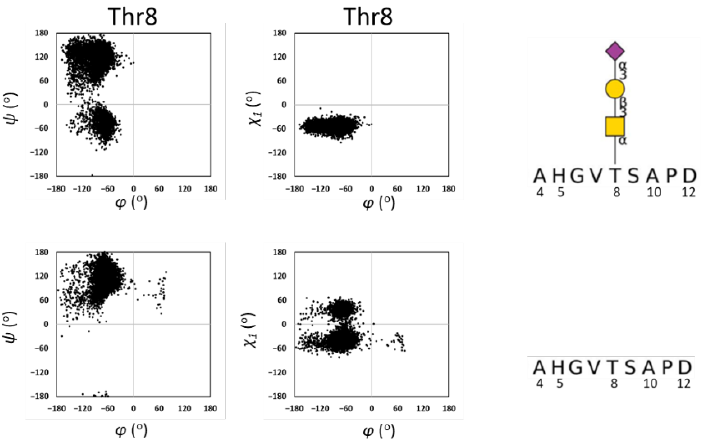
Figure 4. Distribution of dihedral angles of Thr8 of MUC1 obtained by MD simulation. O - glycosylated MUC1 peptide ( top ) and unglycosylated peptide ( below ) were simulated. Symbol nomenclature for glycans (SNFG) is used for presenting O -glycan [19].